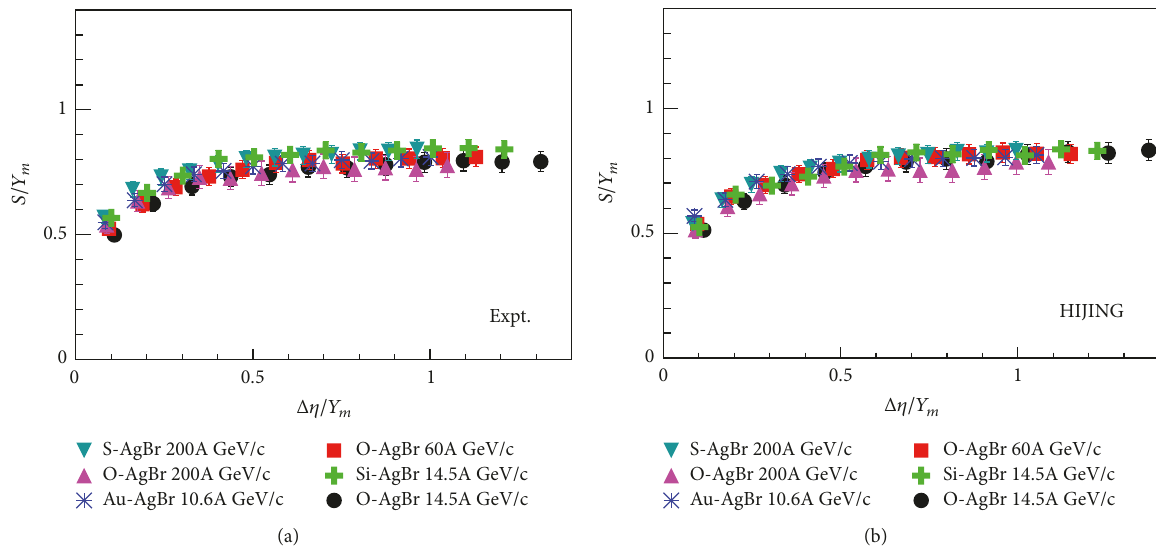
Figure 1: Variations of entropy normalized to maximum rapidity, 𝑆/𝑌 𝑚 , with 𝜂 -window width normalized to maximum rapidity, Δ𝜂/𝑌 𝑚 , for the Experimental (a) and HIJING events (b).